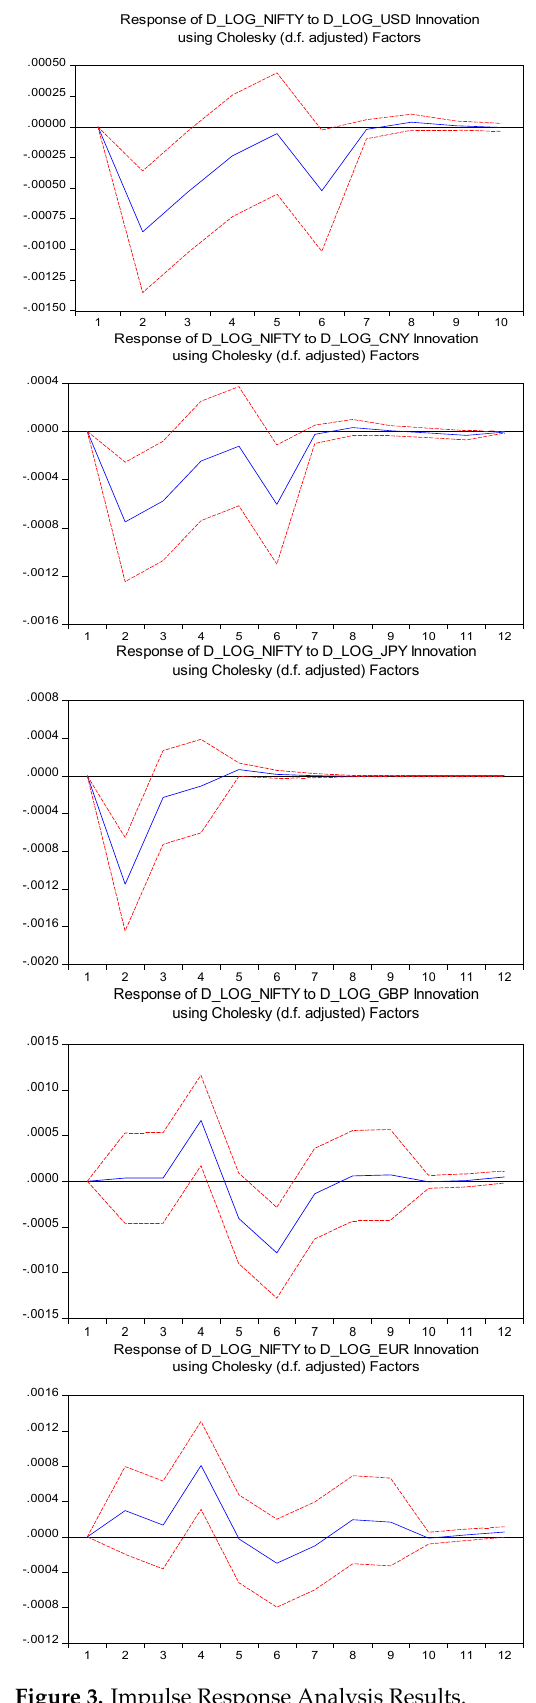
Figure 3. Impulse Response Analysis Results.